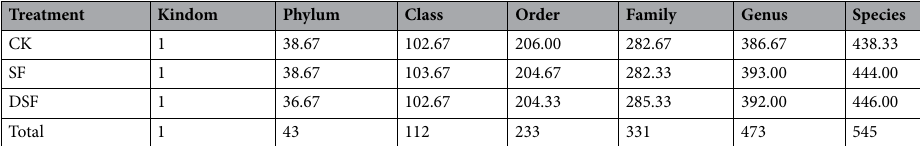
Table 2. The number of species at each level of rice rhizosphere microorganisms under different fertilization modes of slow-release fertilizer. Values are the mean of three replicates.